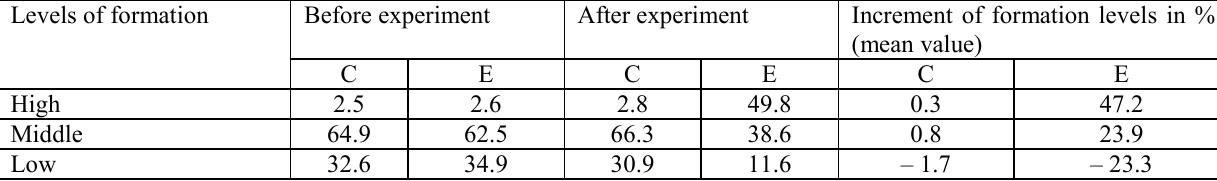
Comparative table of formation levels of responsible attitude in two groups before and after experiment in